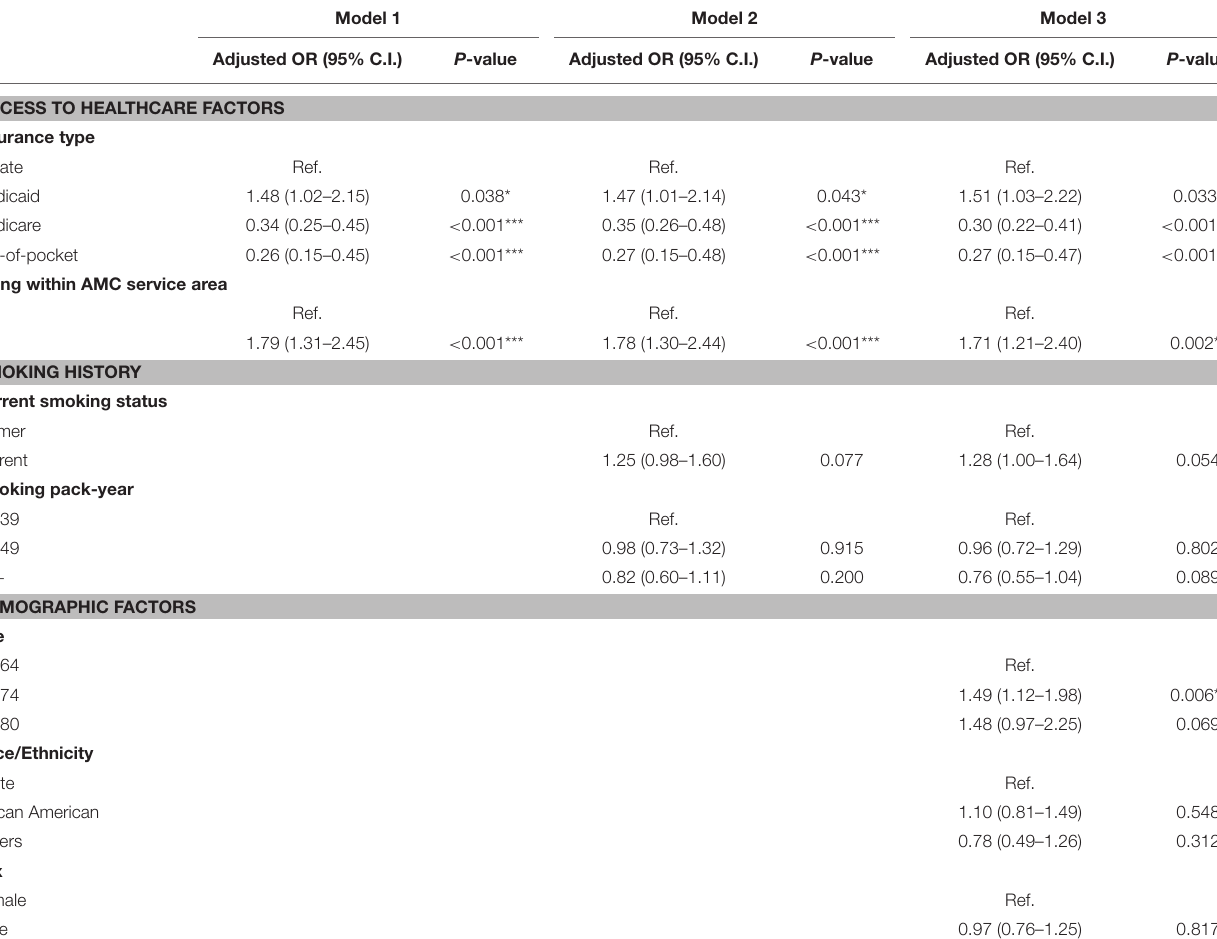
TABLE 3 | Influence of access to healthcare, smoking history, and demographic factors on LDCT screening